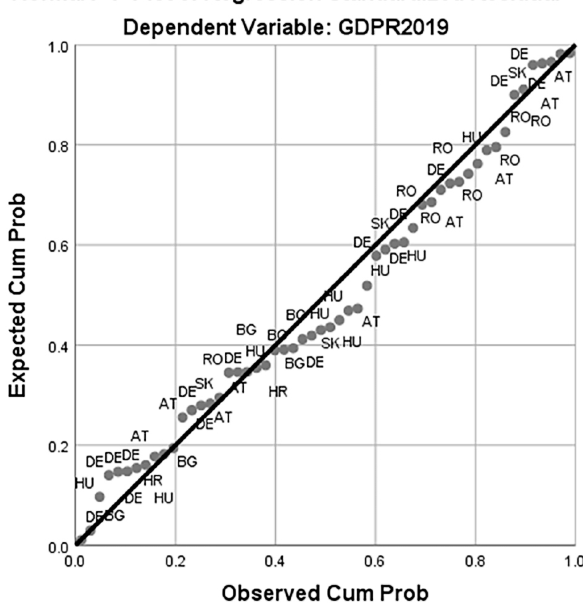
Figure 8. P-P Plot for sustainable development of EUSDR in